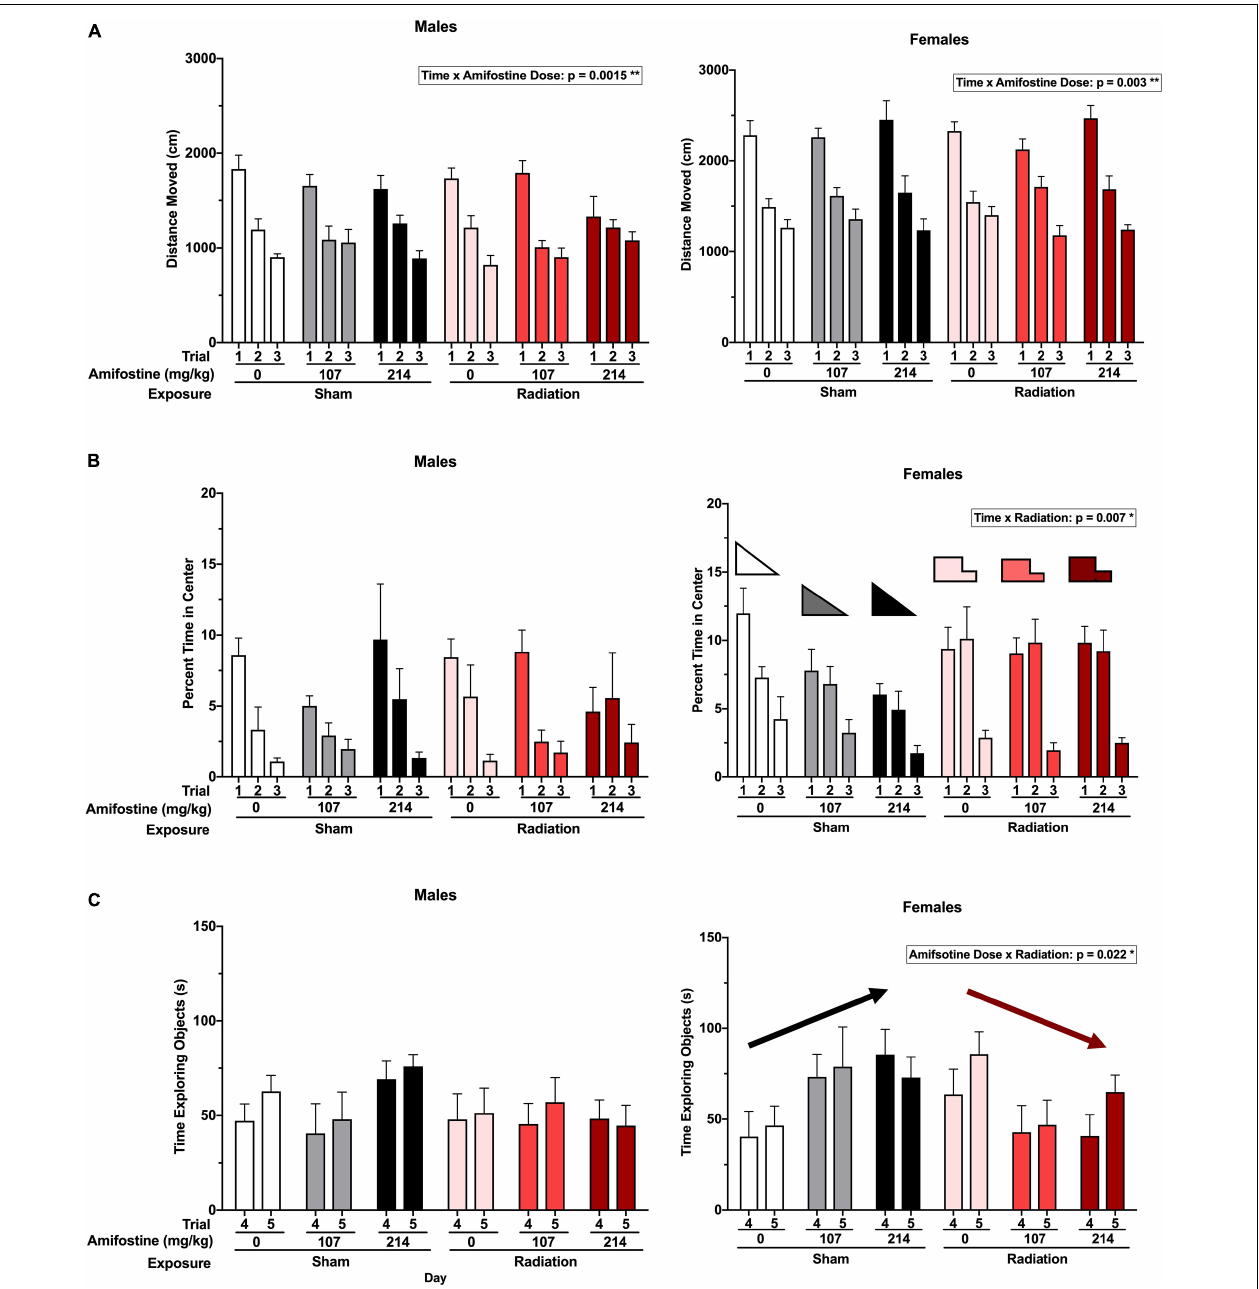
FIGURE 2 | Activity and anxiety-like measures in the open field and novel object tests. (A) The total distance moved (cm) in open field in males ( left ) and females ( right ). A time by amifostine interaction was found in males ( p = 0.0015) and females ( p = 0.003). (B) Percent time in the center of the open field in males ( left ) and females ( right ). Females showed a time by radiation interaction ( p = 0.007). (C) Total time exploring objects over the training and testing day in males ( left ) and females ( right ). Females showed an amifostine by radiation interaction ( p = 0.022). Data are presented as means ± SEMs.